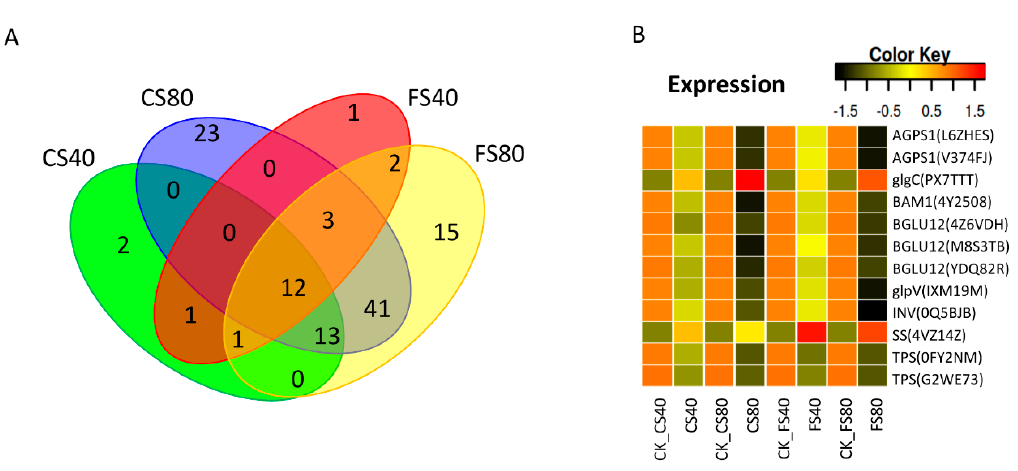
Table 5. Shade commonly regulated DEGs in starch and sucrose metabolism.